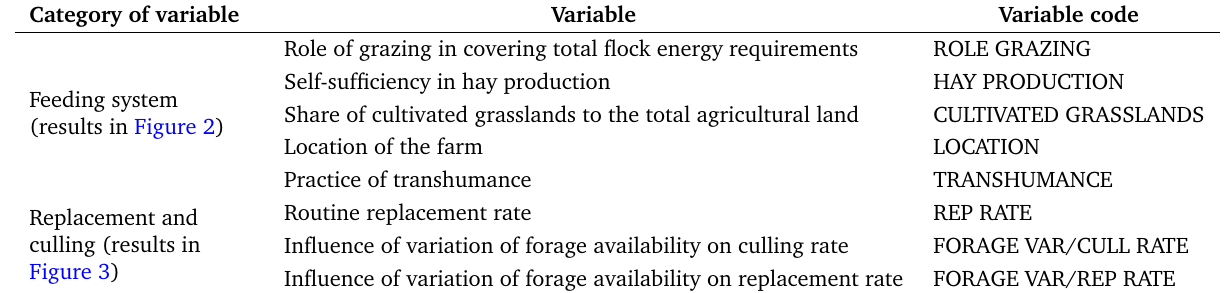
Table 2. Variables built for the analysis of the data derived from the C1 interviews, subsequently used for Bertin’s graphical